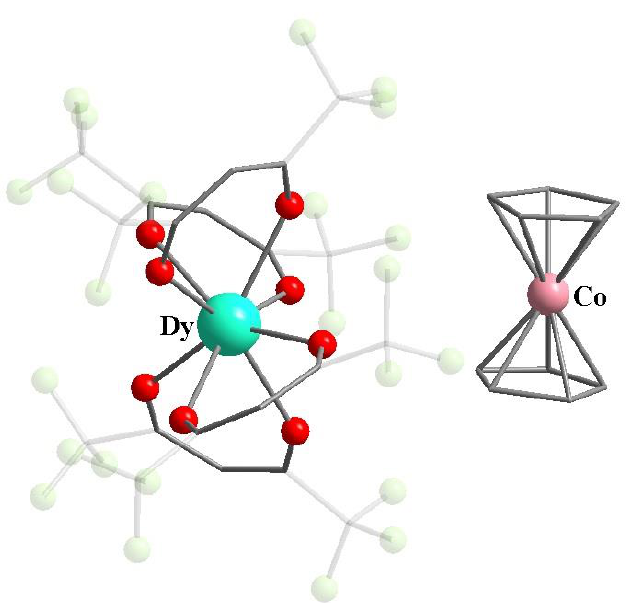
Figure 27. Molecular structure of 53 [96]. Hydrogen atoms have been omitted, some ligands groups are transparent for clarity. The cif has been retrieved from CCDC. CCDC number is 1811780. The β -diketones HL 15 reacted with Ln(III) chloride in the presence of triethylamine